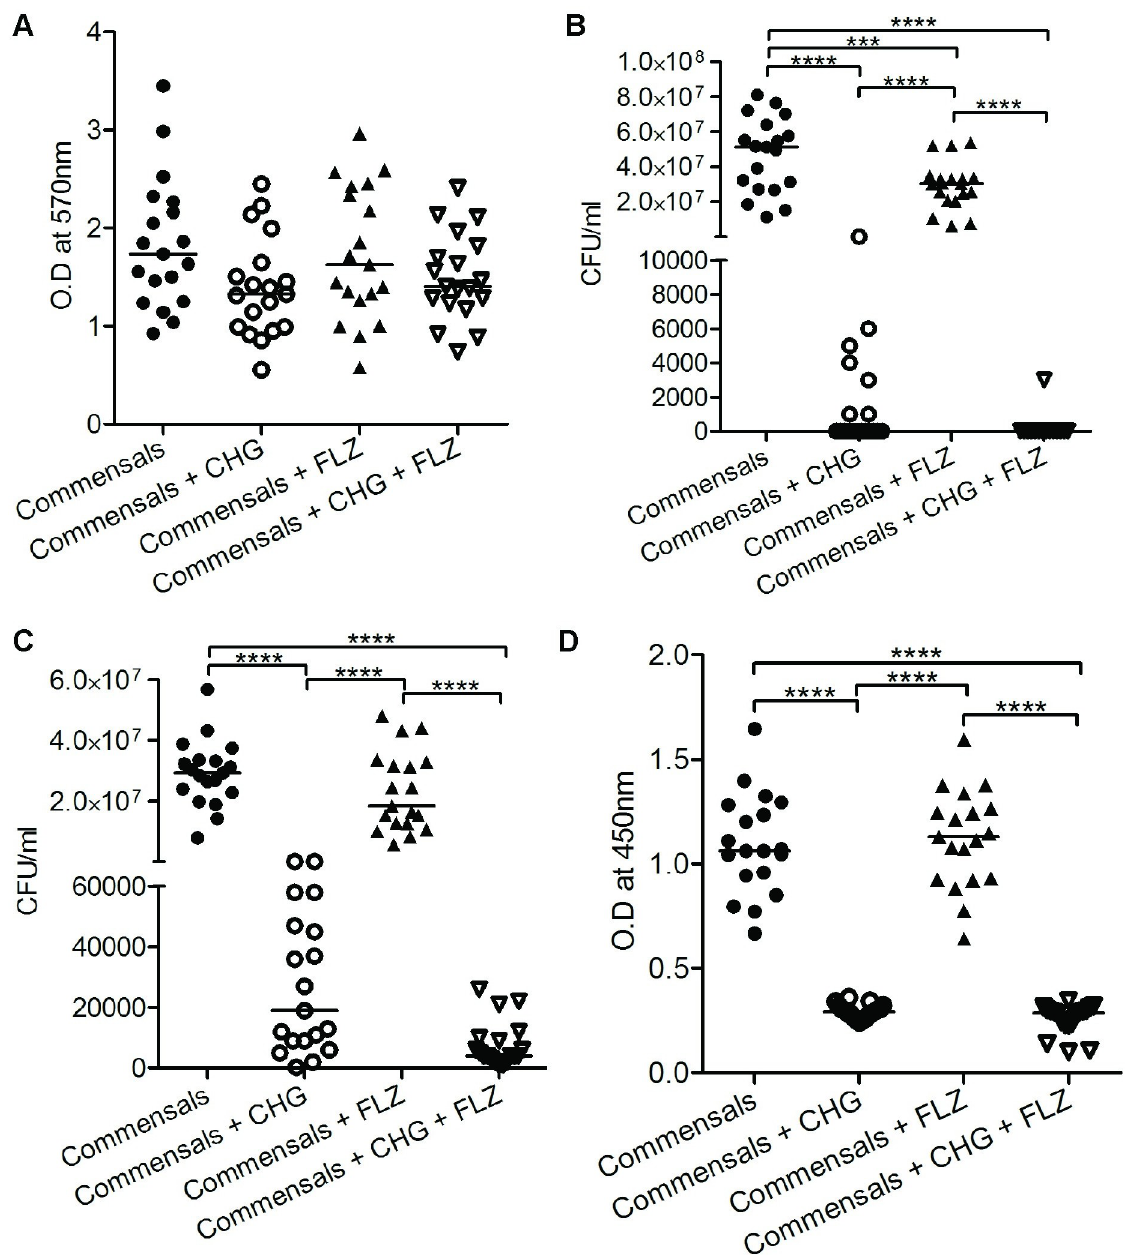
Fig 2. Chlorhexidine digluconate reduces already established biofilm and growth of C . albicans isolates from asymptomatic women. The effect of chlorhexidine digluconate (CHG) 0.02% and fluconazole (FLZ) 4 μ g/ml and the combination CHG + FLZ compared to untreated C . albicans was investigated on commensals strains (n = 19). The density of established, mature, biofilm, measured with crystal violet staining (A), viable count of planktonic C . albicans ( B) and of C . albicans within mature biofilm ( C) . Metabolic active cells within the mature biofilm, measured with XTT assay (D). Individual and median values are presented, depicted as optical density (OD) at 570 nm after dissolution of crystal violet, and at 450 nm for soluble product of formazan crystal after reduction of XTT. � p < 0.05, �� p < 0.01, ��� p < 0.001 and ���� p <